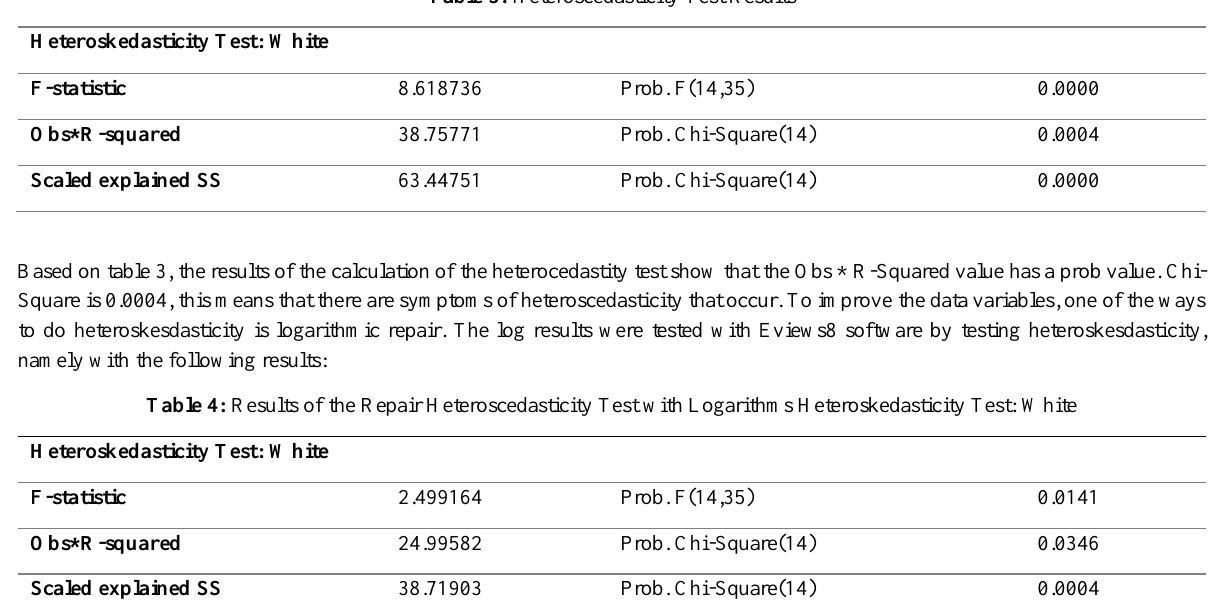
Table 3: Heteroscedasticity Test Results